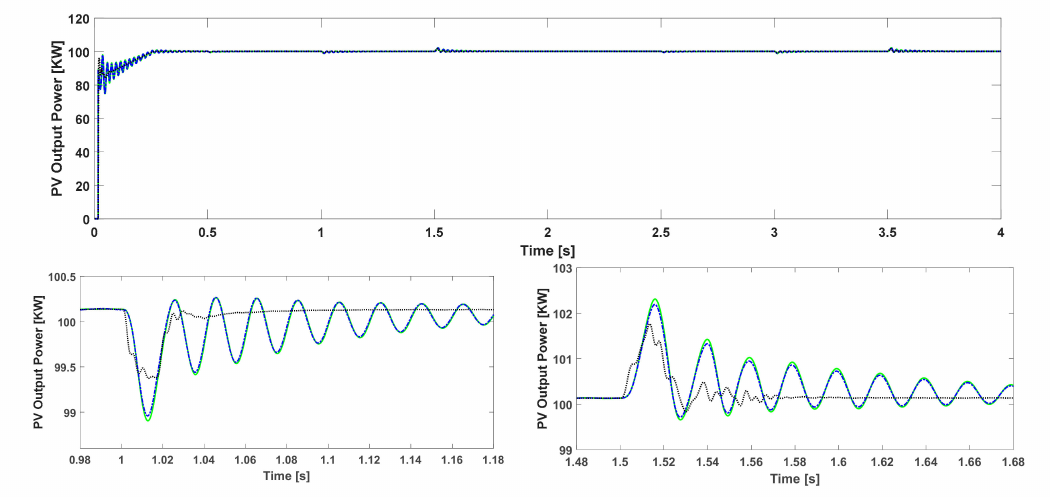
Figure 11. PV array output power during fault-free operation.